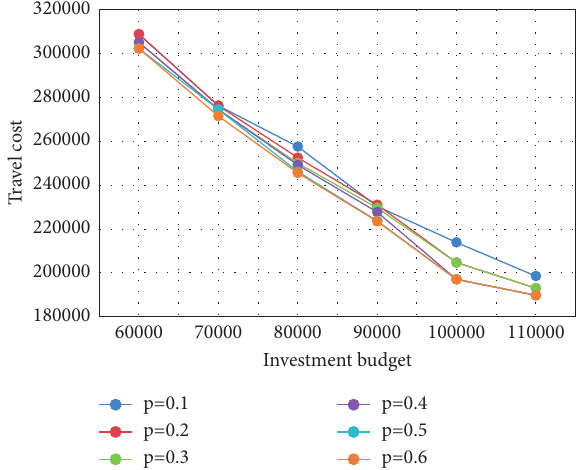
Figure 9: The changing procedure of travel costs according to B and p for Model